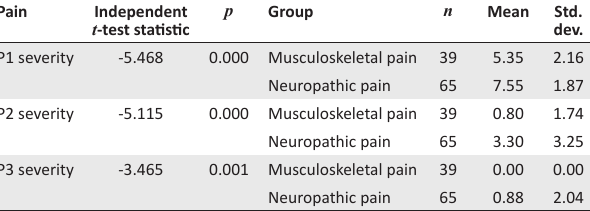
TABLE 5: Differences between musculoskeletal and neuropathic pain ( n = 104). Pain Independent t -test statistic